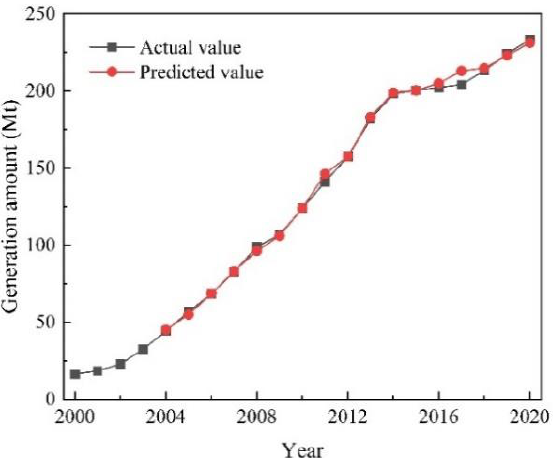
Figure 5. The comparison between the predicted and actual values of CDRW generation.